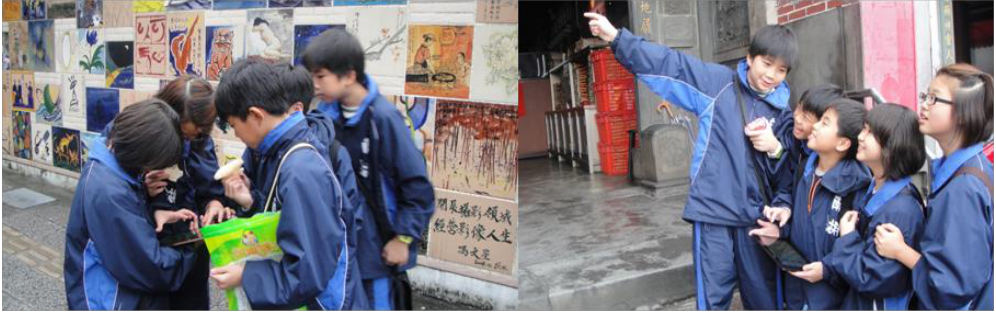
Figure 9. The learning activities of the experimental